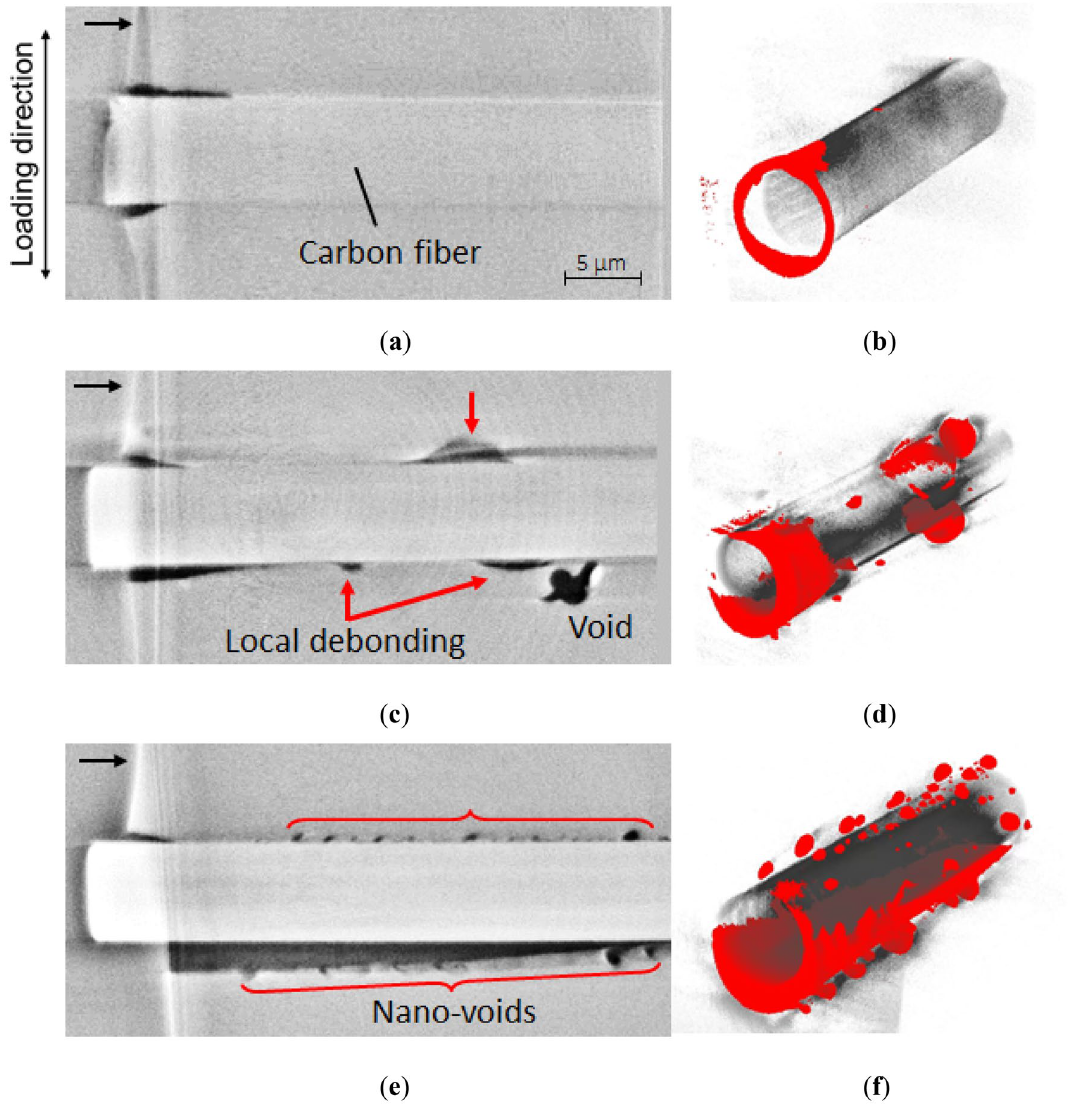
Figure 9. Reconstructed images recorded under stresses of ( a , b ) 30, (c , d ) 40, and ( e , f ) 50 MPa by nano-CT (left) with the 3D image of the carbon fiber extracted using binarization process with empty spaces in the epoxy matrix represented in red. (right). The interfacial debonding was clearly captured from the sample surface even under 30 MPa. The local debonding isolated from the sample surface was also observed under 40 MPa. The interfacial debonding exceeded the field of view under 50 MPa, with an indication of the coalescence of voids prior to the separation from the carbon